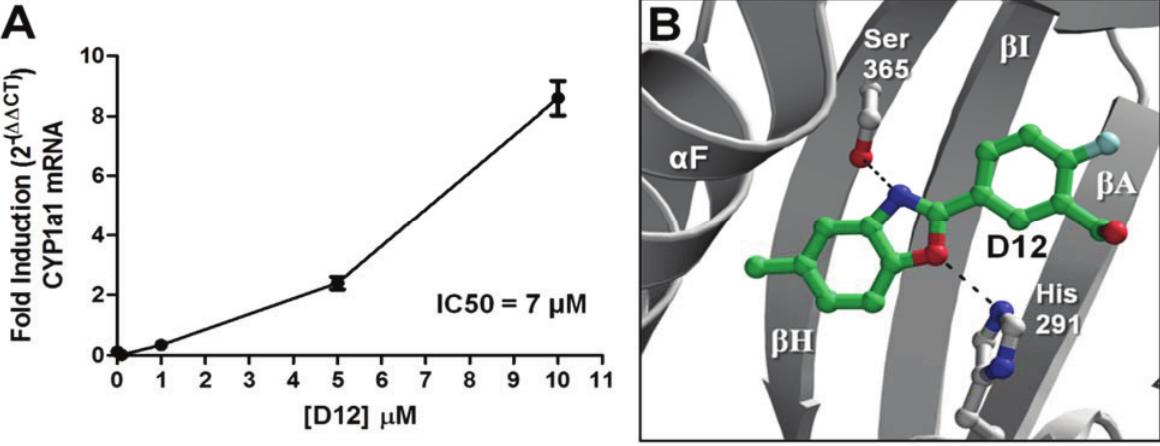
Figure 7. Agonist activity of Compound D12 . ( A ) For dose-dependency of D12 , quantitative reverse transcription-polymerase chain reaction (RT-PCR) for AHR target gene CYP1A1 (Cytochrome p450 1A1) is shown at various [ D12 ] following exposure for 12 h. GAPDH expression was used a control. Experiments were run in triplicate. ( B ) The docking orientation of D12 into the agonist-optimized homology model is shown with the ligand displayed as sticks and colored by atom type as in Figure 2 but with the ligand carbons colored dark green and halogen colored